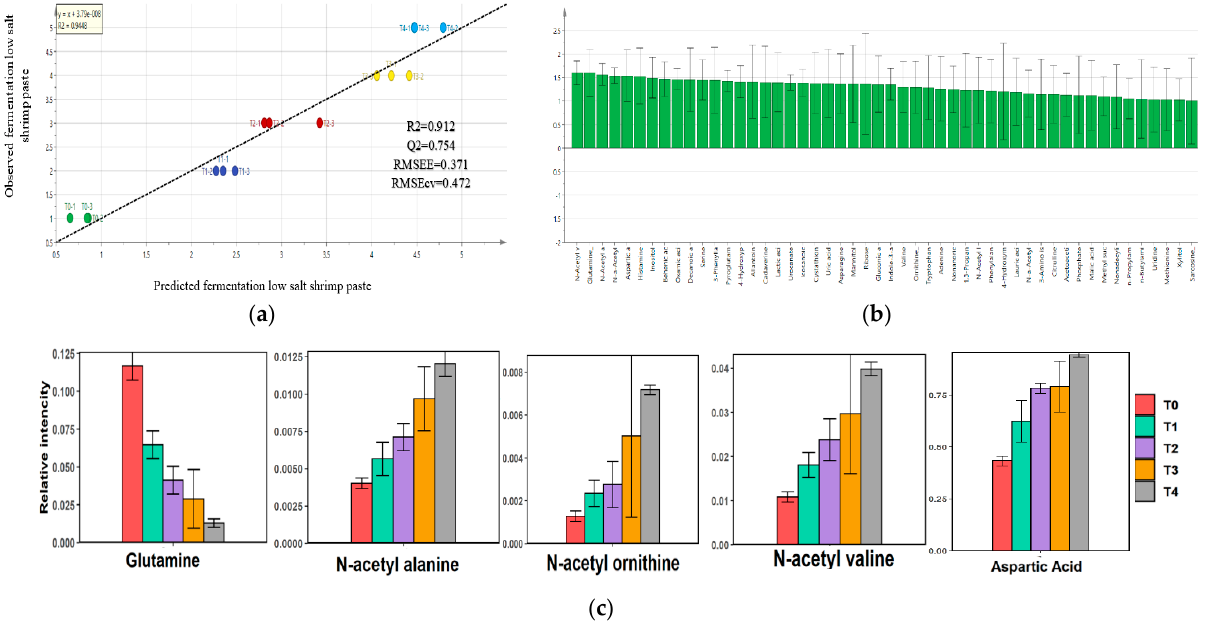
Figure 4. Predicted model of low-salt shrimp paste fermentation. ( a ) OPLS model, ( b ) VIP of metabolites during fermentation of low-salt shrimp paste, and ( c ) top five scores of VIP metabolites during fermentation of low-salt shrimp paste.